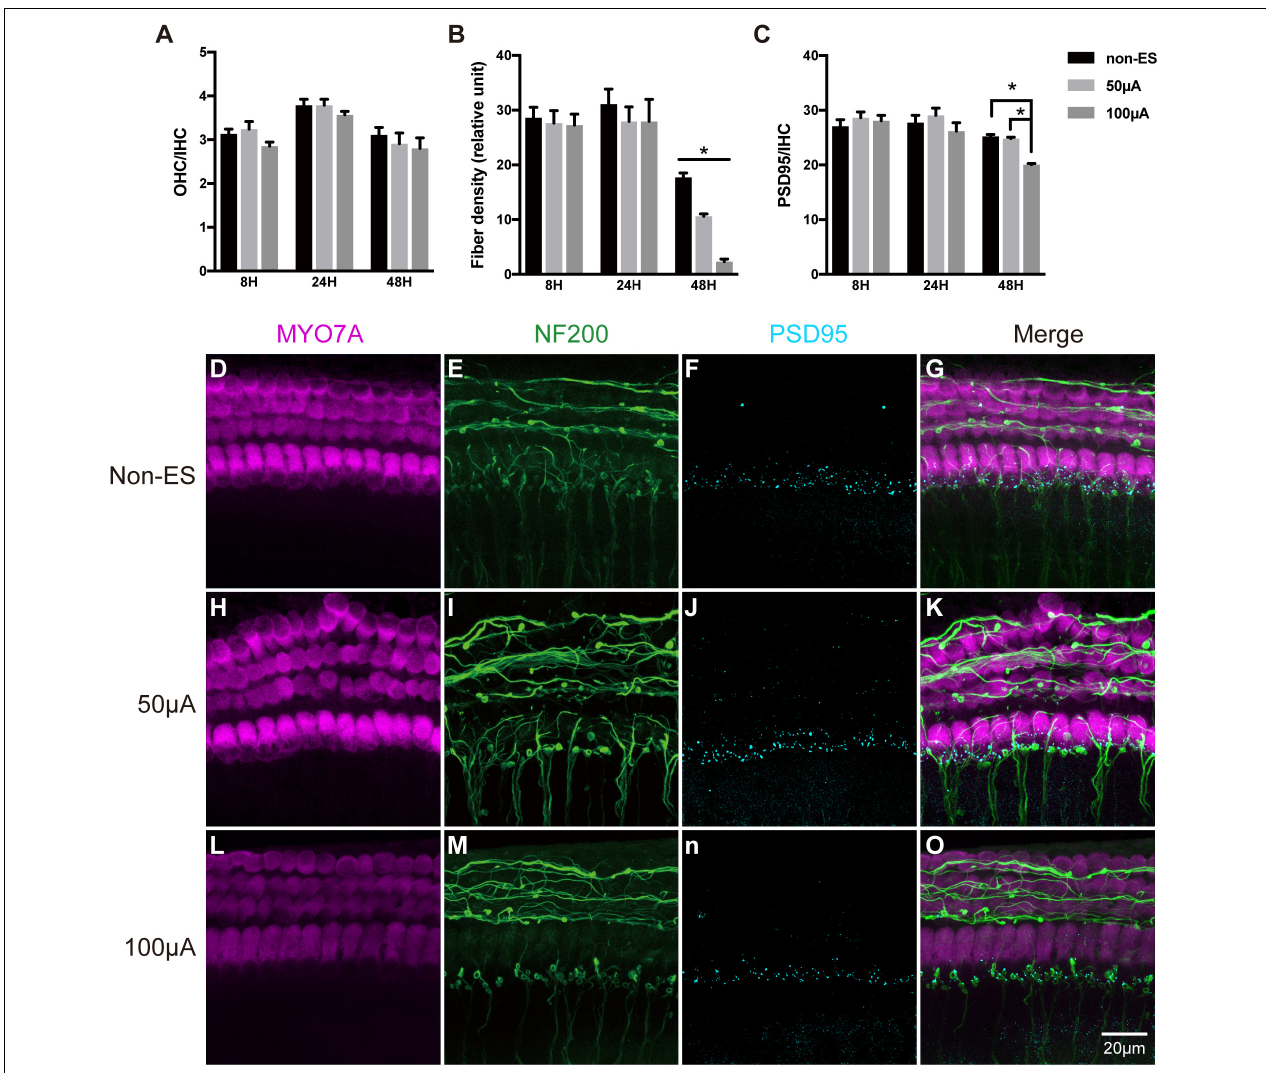
FIGURE 3 | ES did not change the quantity and morphology of hair cells in cochlear explants but induced the loss of IHC synapses and SGN peripheral fibers. (A) After 8, 24 or 48 h of ES, the OHC/IHC ratio was comparable in cochlear explants without ES (non-ES group), under 50 µ A ES and 100 µ A ES (8 h/50 µ A, P = 0.8955; 8 h/100 µ A, P = 0.4851; 24 h/50 µ A, P > 0.9999; 24h/100 µ A, P = 0.5872; 48 h/50 µ A, P = 0.6174 and 48 h/100 µ A, P = 0.3631), n = 9–20 in each group. (B) The density of SGN peripheral fibers significantly decreased after 48 h/50 µ A and 48 h/100 µ A ES compared to the non-ES group ( P = 0.0097, P < 0.0001, respectively), while the fiber density in explants after 8 h or 24 h ES was comparable to that in non-ES explants (8 h/50 µ A, P = 0.9096; 8 h/100 µ A, P = 0.8528; 24 h/50 µ A, P = 0.4702; 24 h/100 µ A, P = 0.4854), n = 9–20 in each group. (C) The PSD95/IHC ratio in explants with 48 h/100 µ A ES was significantly different from that in non-ES explants ( P < 0.0001), while PSD95/IHC ratio in explants with other treatments was comparable to that in non-ES explants (8 h/50 µ A, P = 0.4526; 8 h/100 µ A, P = 0.7005; 24 h/50 µ A, P = 0.5011; 24 h/100 µ A, P = 0.3921; 48 h/50 µ A, P = 0.9170), n = 9–20 in each group. (D–O) Typical images of cochlear explants treated with 48 h/non-ES (D–G) , 48 h/50 µ A ES (H–K) , and 48 h/100 µ A ES (L–O) . The quantity and morphology of IHCs and OHCs (in magenta, labeled with anti-Myo7A) were comparable in explants treated with non-ES (D) , 50 µ A ES (H) and 100 µ A ES (L) . The density of SGN peripheral fibers (in green, labeled with anti-neurofilament-200, NF200) in explants treated with 50 µ A (I) or 100 µ A ES (M) was less than that in explants treated with non-ES (E) . The number of IHC synapses (in cyan, labeled with anti-PSD95) in explants treated with 100 µ A ES (N) was much less than that in explants treated with 50 µ A ES (J) or non-ES (F) . ∗ P < 0.05. Data represent the mean + SEM. Two-way ANOVA followed by Dunnett’s multiple comparisons test was used in all the experiments mentioned